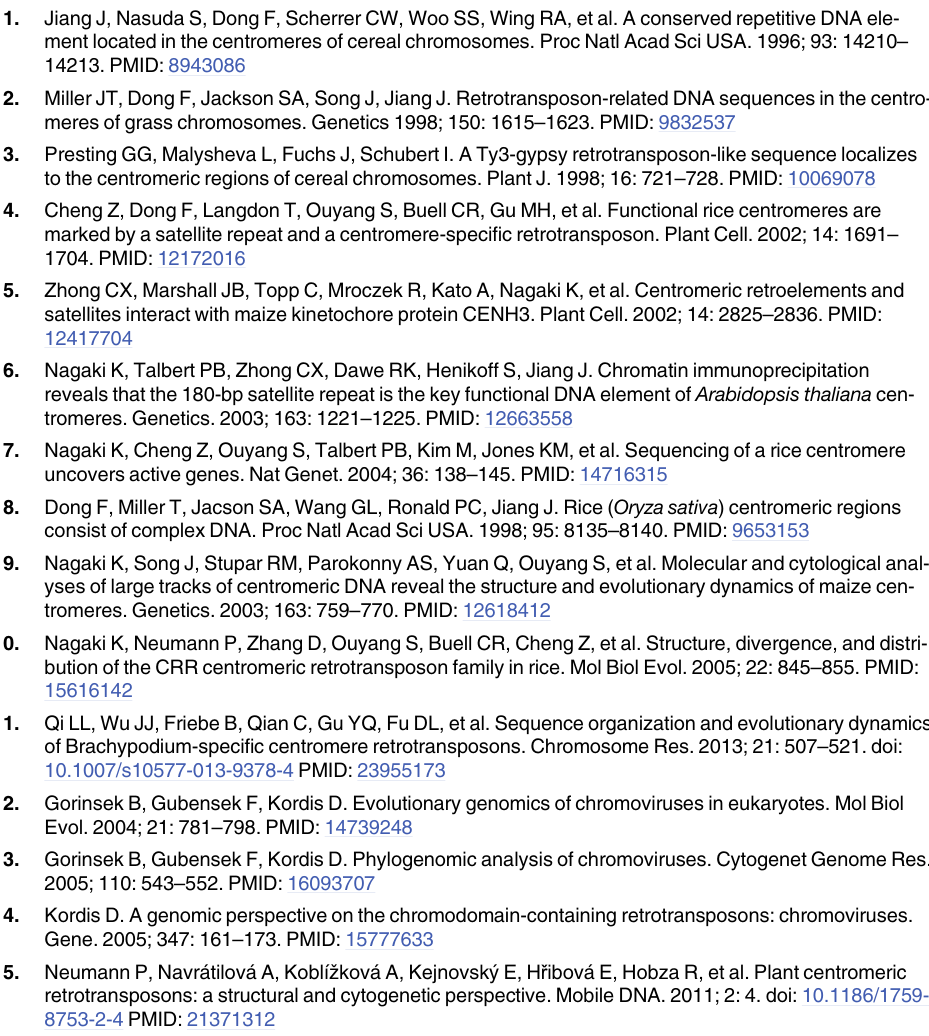
used in qPCR analysis are indicated in arrows and color highlighted.